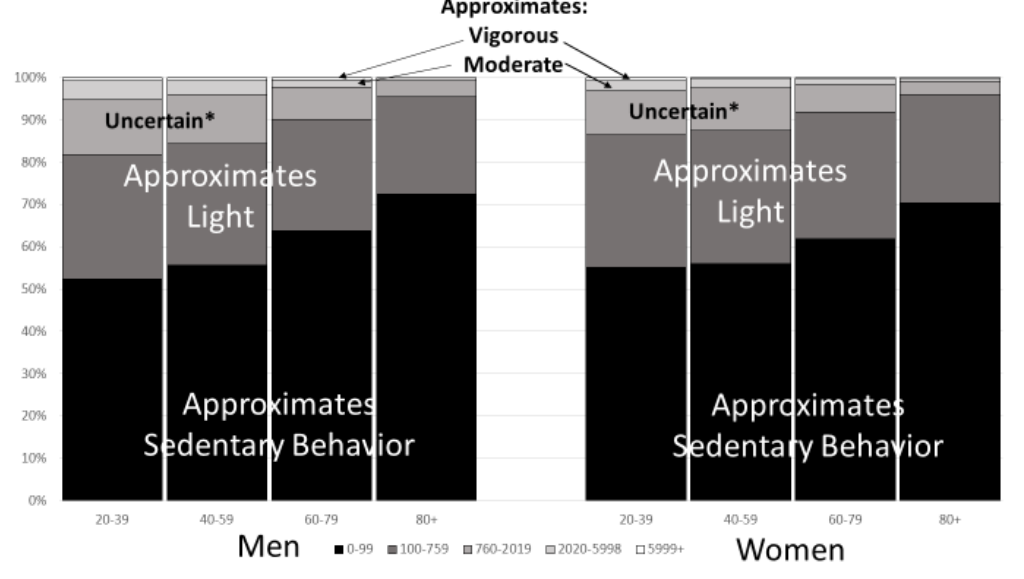
Figure C-1. Proportion of Time-awake at Different Categories of Accelerometer Counts for U.S. Adults, by Sex and Age Group,